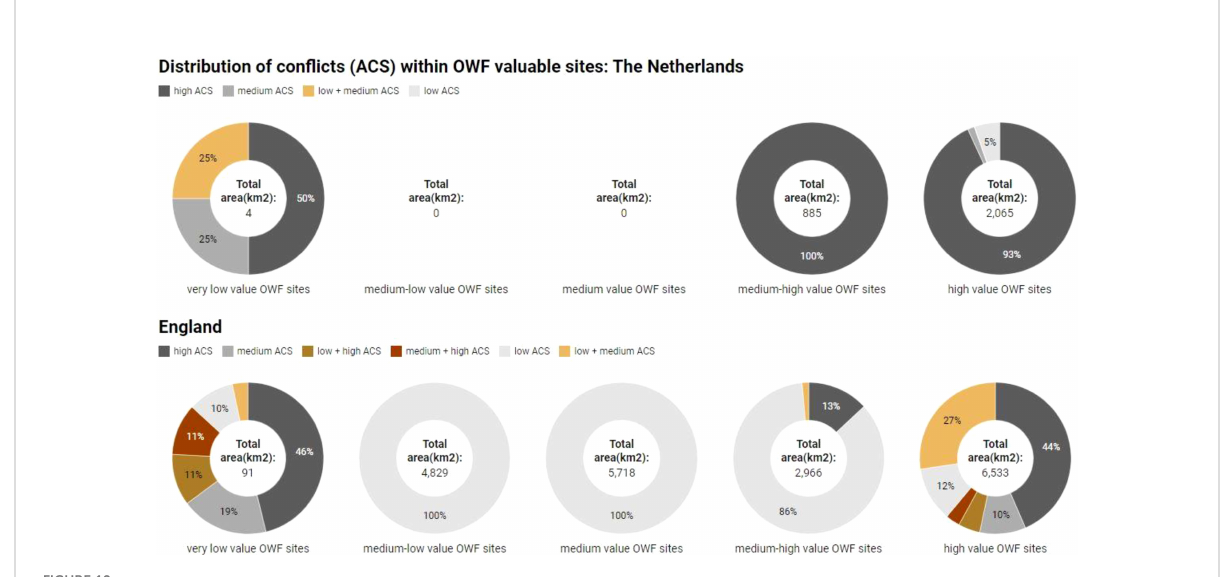
FIGURE 10 Average con fl ict resolution scores for the interaction between OWFs and military/aviation